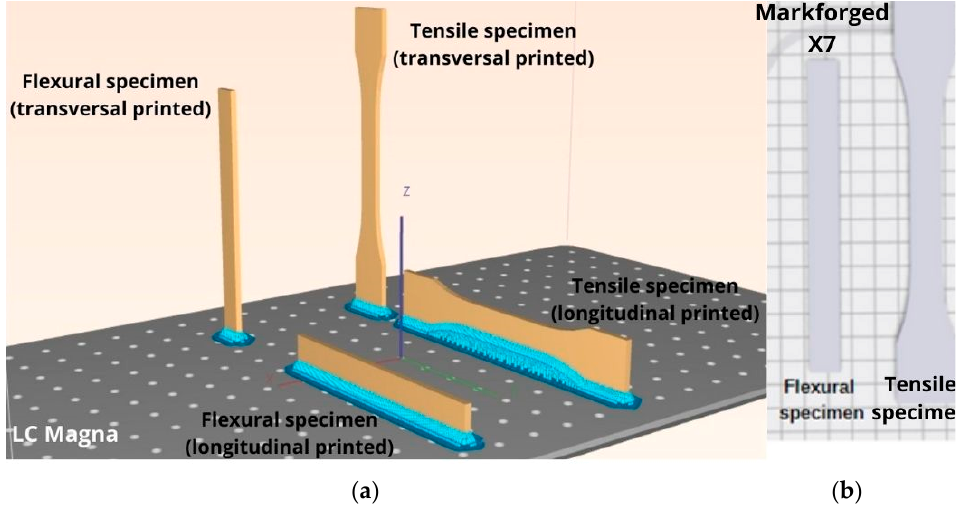
Figure 1. ( a ) Static mechanical test specimens’ printing directions on ( a ) LC Magna; ( b ) Markforged